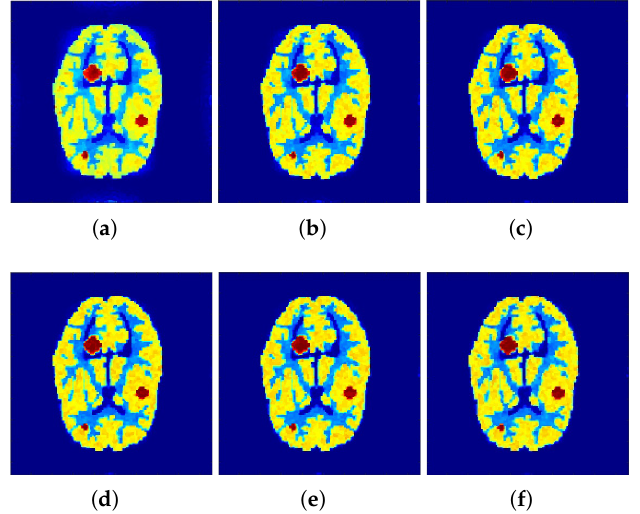
Figure 4. f -MLEM Intermediate MLEM reconstructions. ( a – c ) row: iterations 20, 40, and 60. ( d – f ) row: iterations 80, 100, and